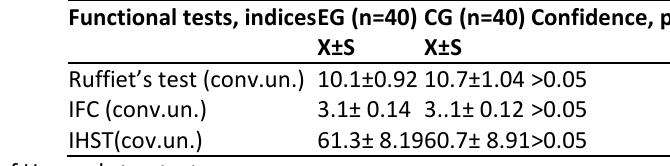
Table 1. Indicators of EG and CG students’ functional fitness at the beginning of experiment (n = 80)